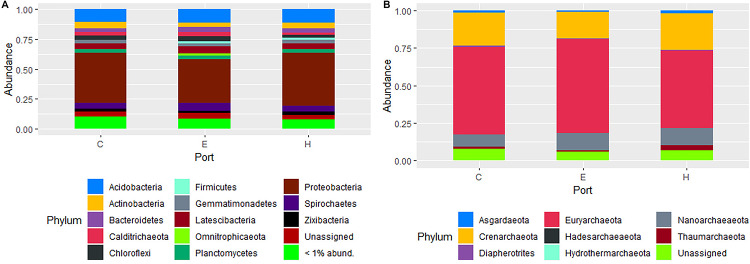
Composition of prokaryotic communities in surface sediments of the study ports (C: Cagliari, E: El Kantaoui, and H: Heraklion). Bar plot showing the average contribution for each port of Bacteria (A) and Archaea (B) at phylum level. Taxa that on average comprised less than 1% of the libraries were grouped. The station H5 was excluded from calculation of average values for the Heraklion port.